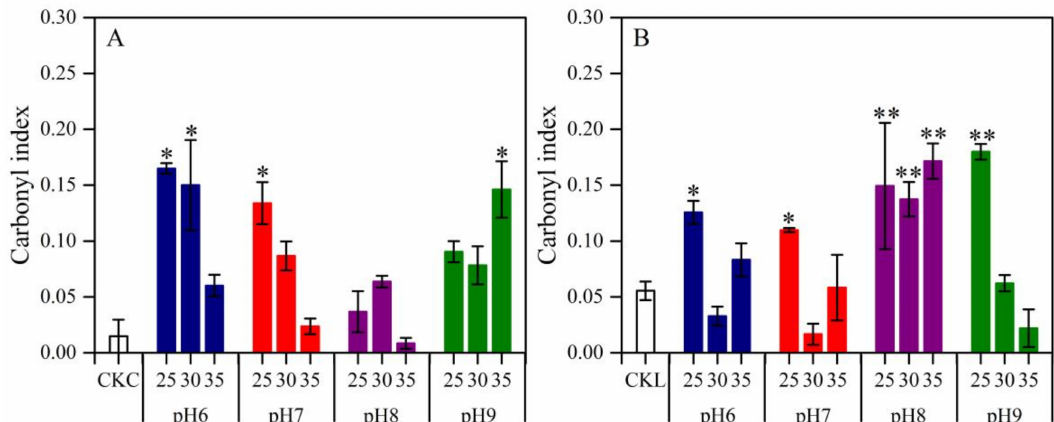
Figure 3. E ff ect of pH (6–9) and temperature (25–35 ◦ C) on polyethylene film carbonyl index in the presence of Arthrobacter sp. ( A ) and Streptomyces sp. ( B ). CKC and CKL indicate polyethylene film without bacteria in Czapek–Dox and liquid carbon-free basal medium at 25 ◦ C in pH 7, respectively. Bars indicate the mean ± SE (n = 3), and bars with asterisk di ff er significantly from CKC ( A ) or CKL ( B ). * p < 0.05, ** p < 0.01.